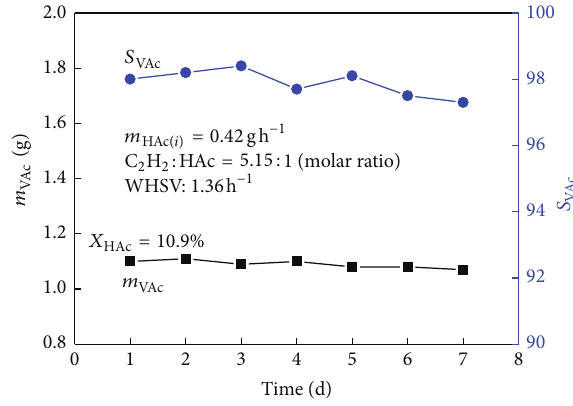
Figure 9: Lifetime experiment of